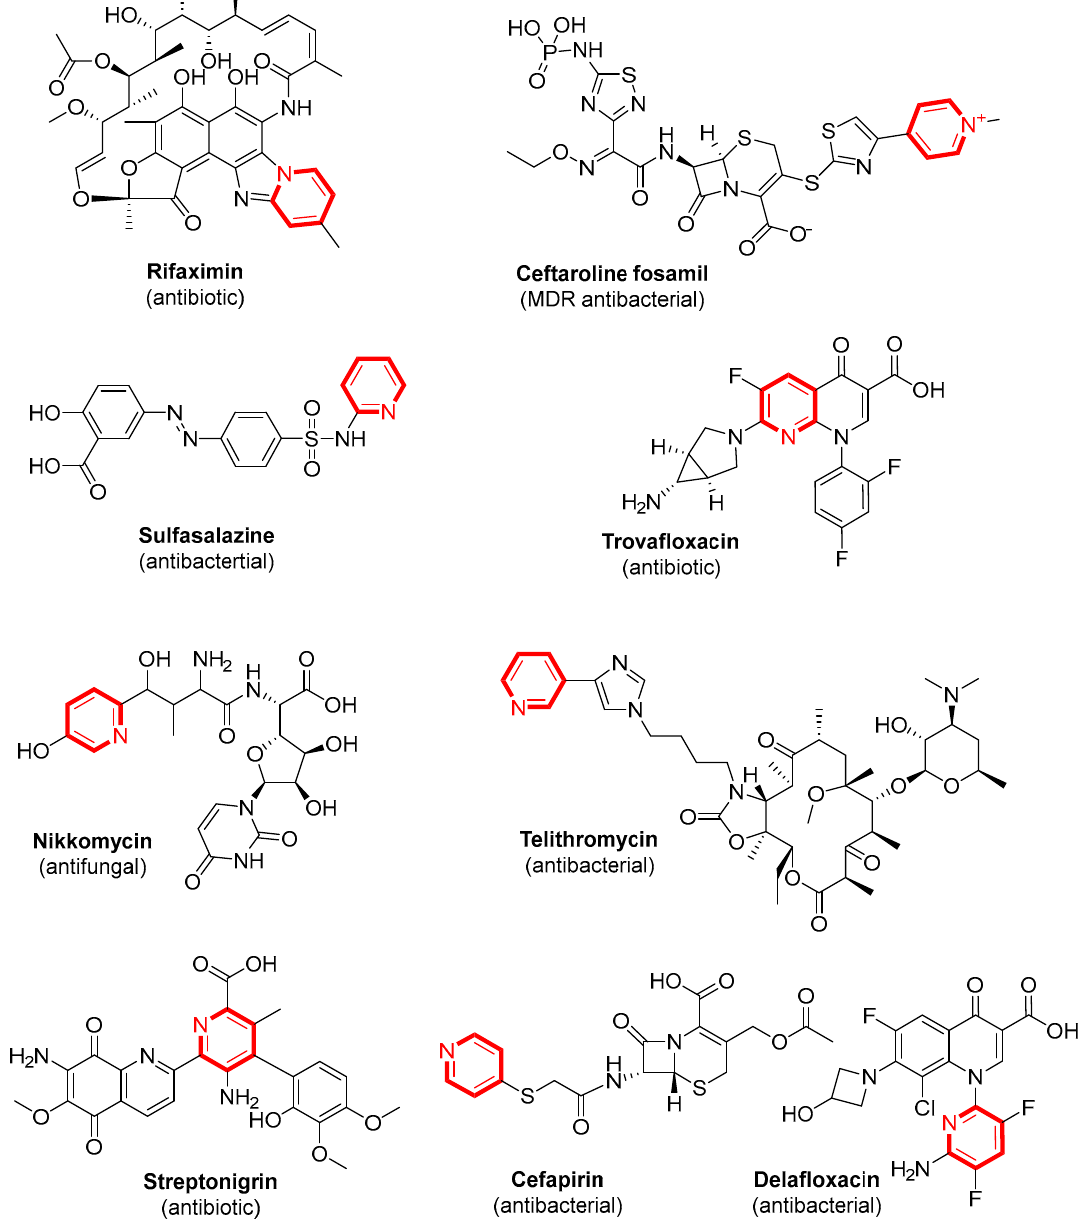
Figure 2. Broad-spectrum antibiotics containing pyridine scaffolds.